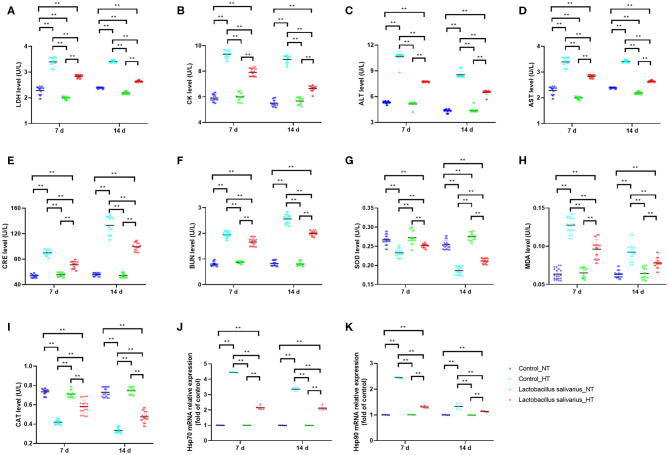
Effects of dietary Lactobacillus salivarius supplementation on the response of chickens to circular heat stress. (A–F) serum metabolic enzyme activity, which were measured at 7 and 14 days post-exposure to circular heat stress (n = 20). (G–I) Oxidative stress-related enzymes of ileum tissue, which were measured at 7 and 14 days after exposure to circular heat stress (n = 20). (J–K) Hsp70 and Hsp90 mRNA expression levels of ileum tissue in each group, which were measured 7- and 14-days post-exposure to circular heat stress (n = 5). Each point represents a single bird and bars represent mean ± SD. Two-way ANOVA for repeated measurements, followed by Tukey tests. ** indicates P < 0.01.